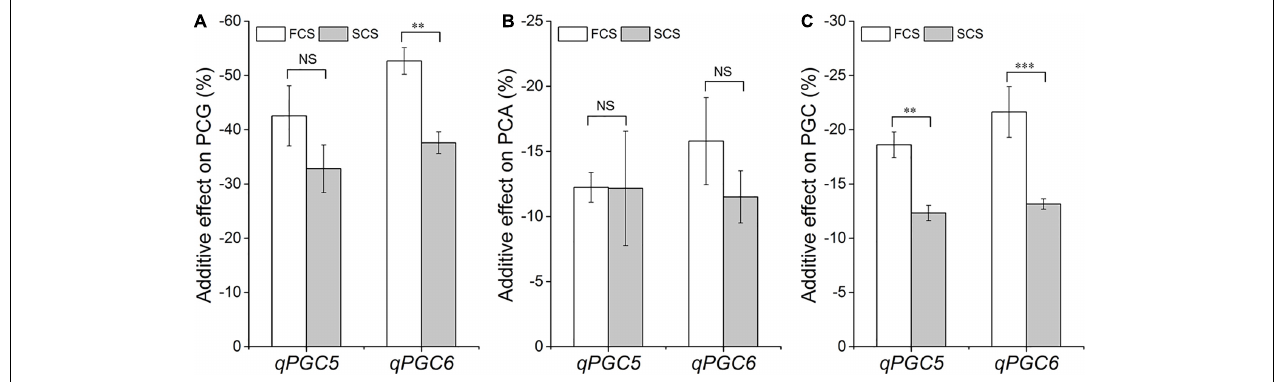
FIGURE 5 | The additive effects of qPGC5 and qPGC6 on grain chalkiness in the first cropping season (FCS) and the second cropping season (SCS). (A) PCG, Percentage of chalky grain. (B) PCA, Percentage of chalky area. (C) PGC, Percentage of grain chalkiness. ∗∗ and ∗∗∗ , Significant difference at the 0.01 and 0.001 levels, respectively. NS, No